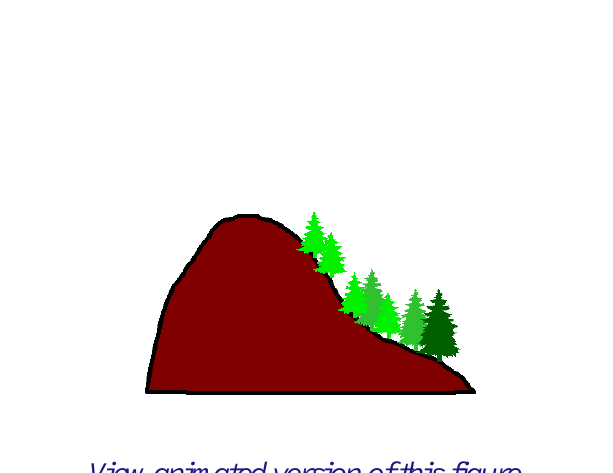
Fig. 3. A simple depiction of ecosystem replacement on an oceanic island such as Krakatoa. The volcano changes the topography of the island and covers it in ash and lava, creating a different abiotic environment. Recolonization occurs at random from bird-dispersed seeds that differ substantially from those of the vegetation that was there prior to the volcano. Spatiotemporal continuity of the ecosystem is completely lost in this